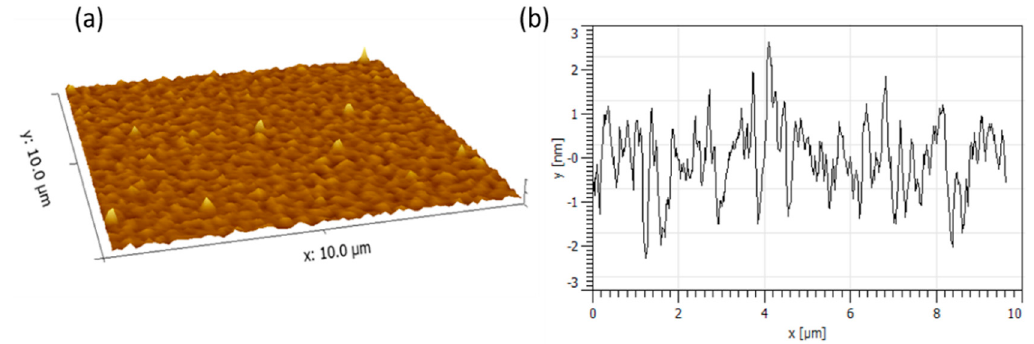
Figure 4. ( a ) 3D AFM topography scan of SiOC film surface (color scale from -5 nm to + 5 nm); ( b ) 1D measured profile of AFM image: a peak-to-valley roughness of about 2 nm is observed that agrees well with surface roughness estimated with spectroscopic ellipsometry.